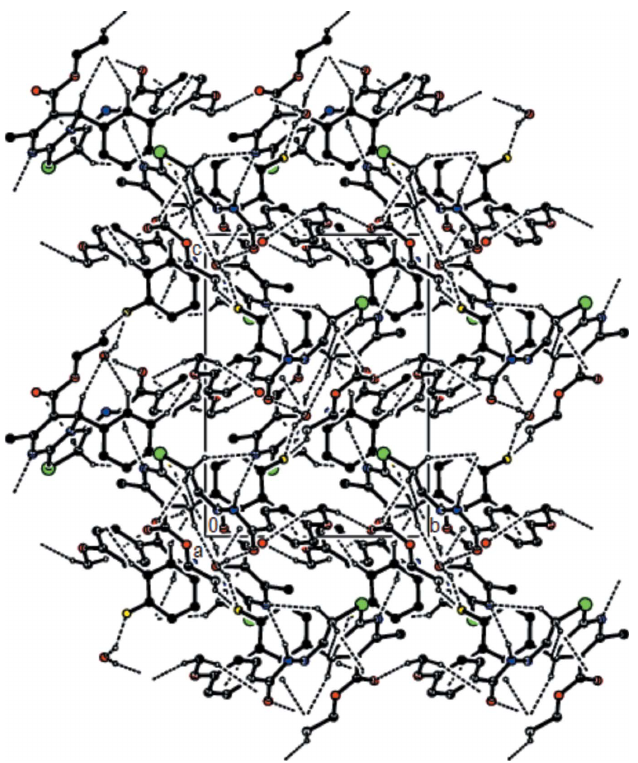
Figure 2 View of the molecular packing along [100]. O—H (cid:2)(cid:2)(cid:2) O, O—H (cid:2)(cid:2)(cid:2) F, C— H (cid:2)(cid:2)(cid:2) O, C—H (cid:2)(cid:2)(cid:2) N and C—H (cid:2)(cid:2)(cid:2) F hydrogen bonds are shown as dashed lines.